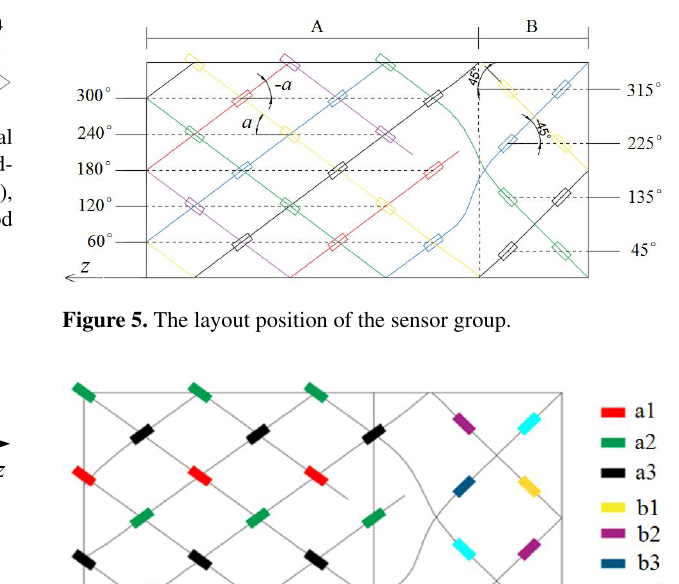
Figure 4. Three-layered structure mode of the hollow inclusion cell.